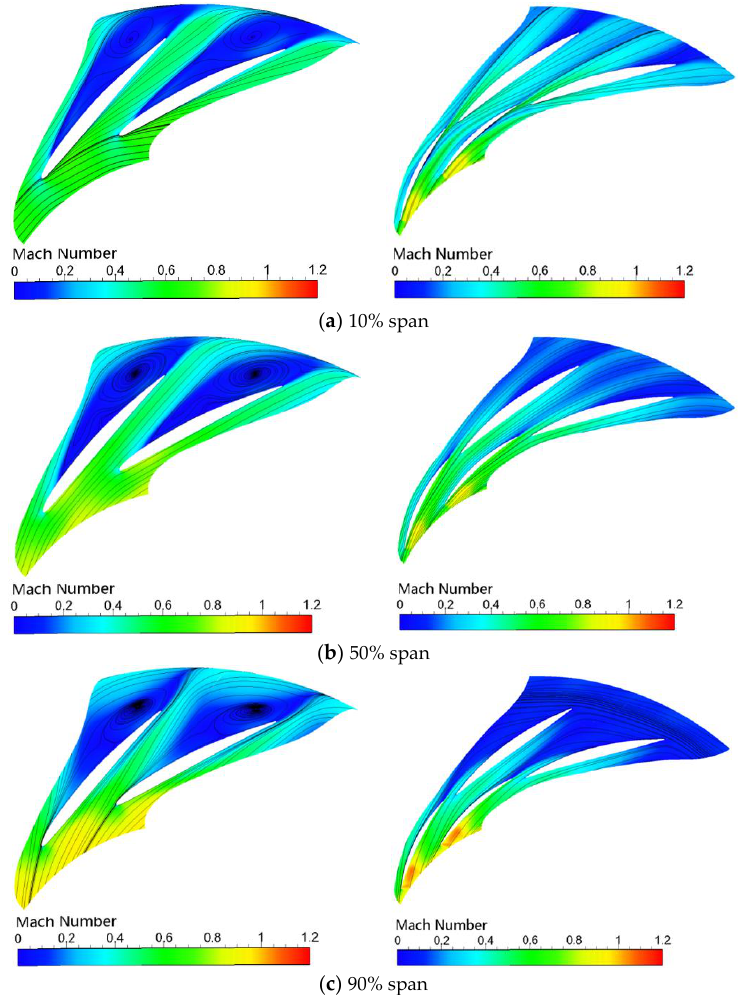
Figure 18. Mach number distribution at different spans of the original and optimized designs of the low-pressure-stage centrifugal compressor at 90%